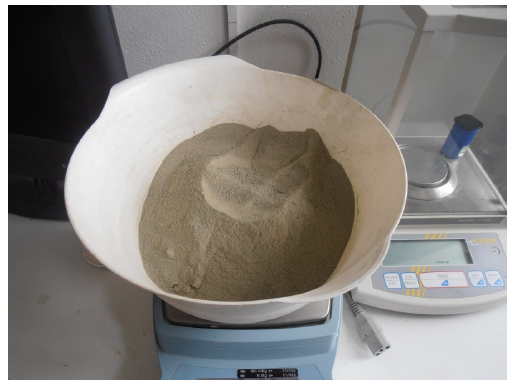
Figure 7. Montmorillonite clay.